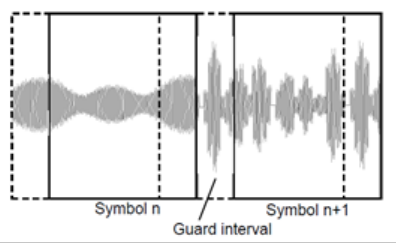
Figure 4. Spectral Envelope of DVB- T2 Signal.